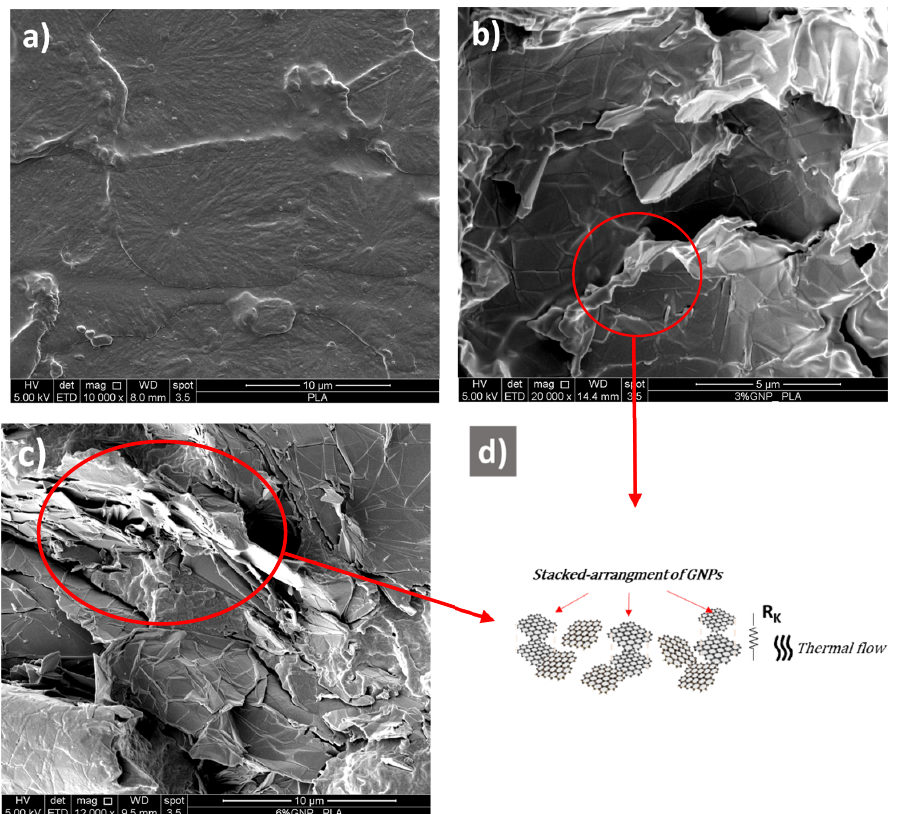
Figure 4. SEM images of neat PLA and the two nanocomposites, including 3 and 6 wt% of GNPs in ( a – c ), respectively. A schematic stacked arrangement of the graphene particles is depicted in ( d ).